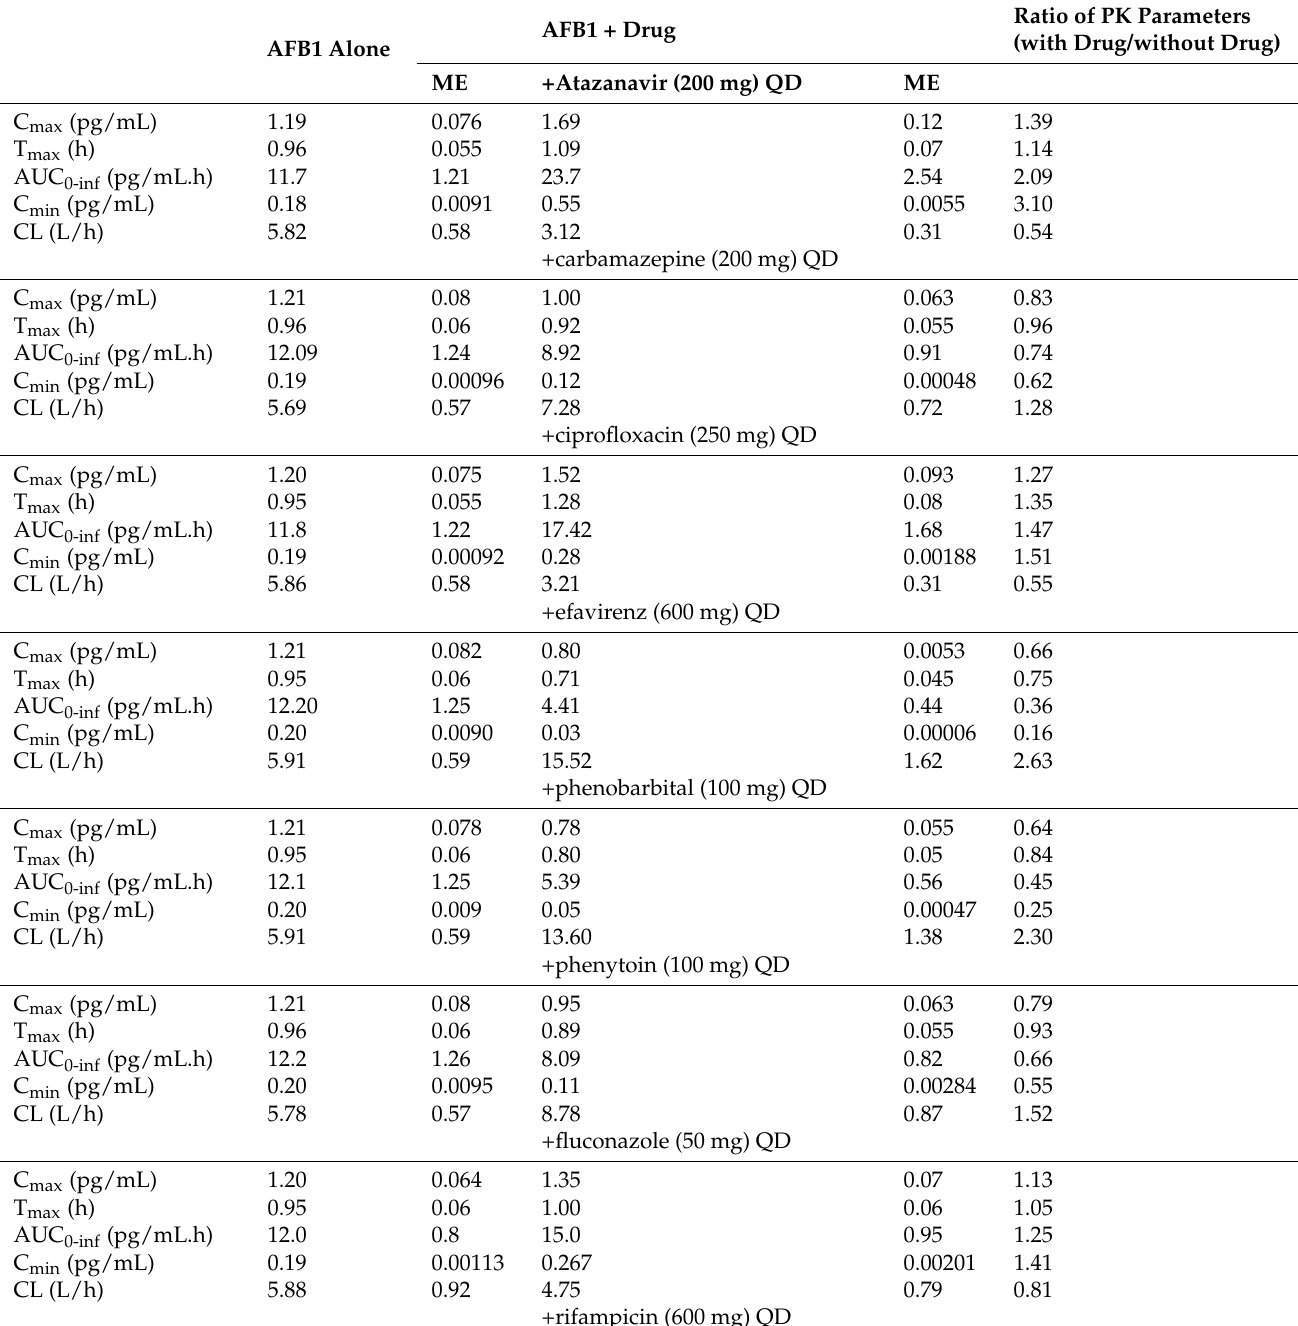
Table 7. Overview of C max , T max , AUC, C min and CL (D/AUC) (+mean error) for AFB1 alone and in combination with other drugs. AFB1 + Drug